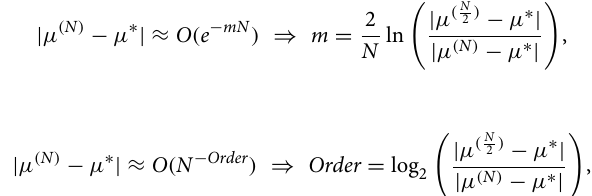
Figure 1. Convergence behavior for the chemical potentials of